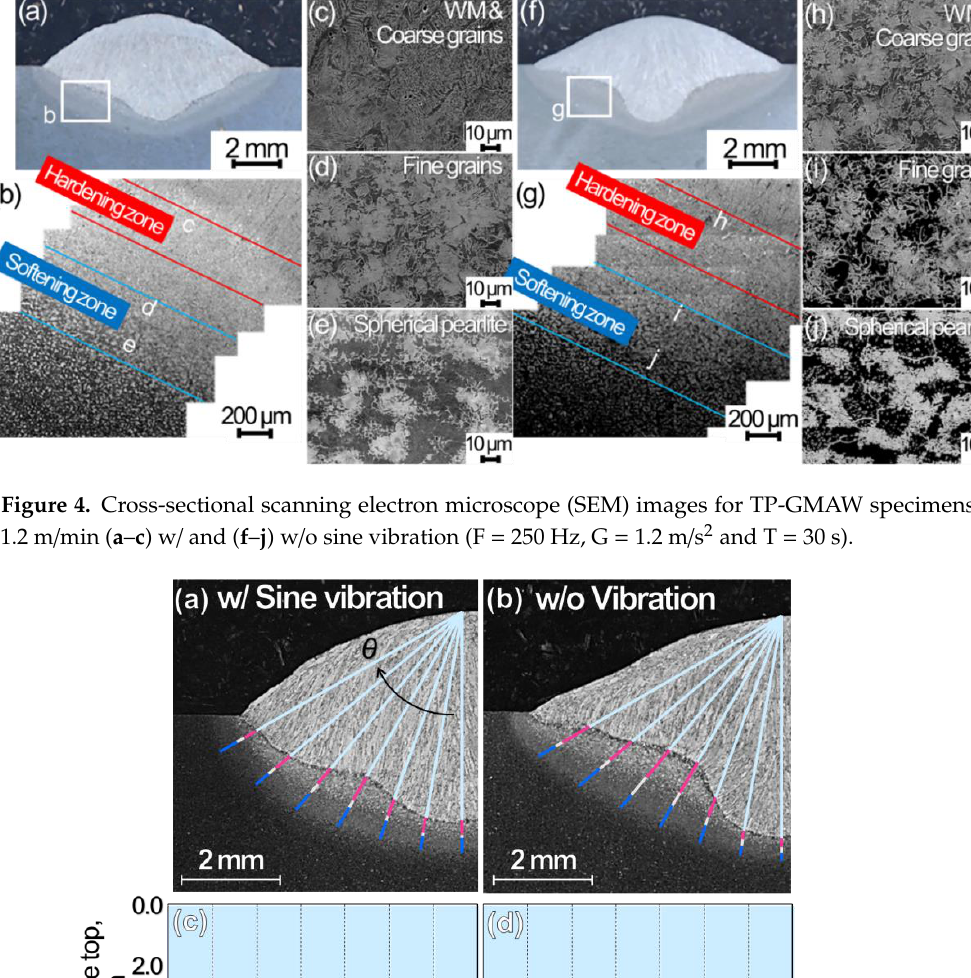
Figure 3. Cross-sectional ( a ) OM image and ( b–d ) electron back-scatter diffraction-inverse pole figure (EBSD-IPF) maps for TP-GMAW specimens at 1.2 m/min w/ sine vibration (F = 250 Hz, G = 1.2 m/s 2 and T = 30 s).